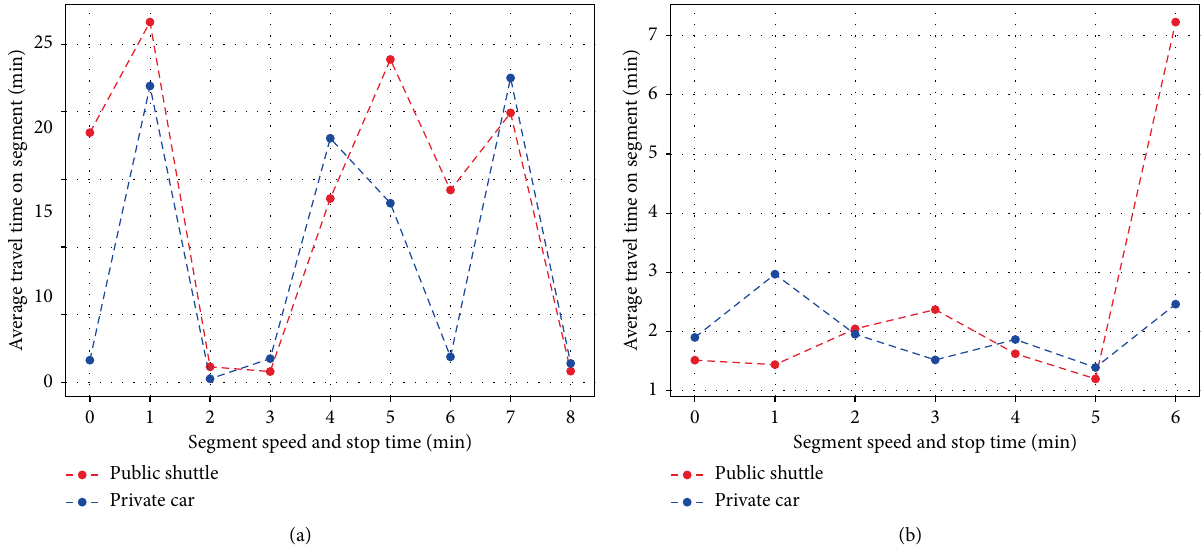
Figure 7: Travel time estimate from (a) Anloga junction to Mckeon, and (b) Oduom to Tech junction for private and public